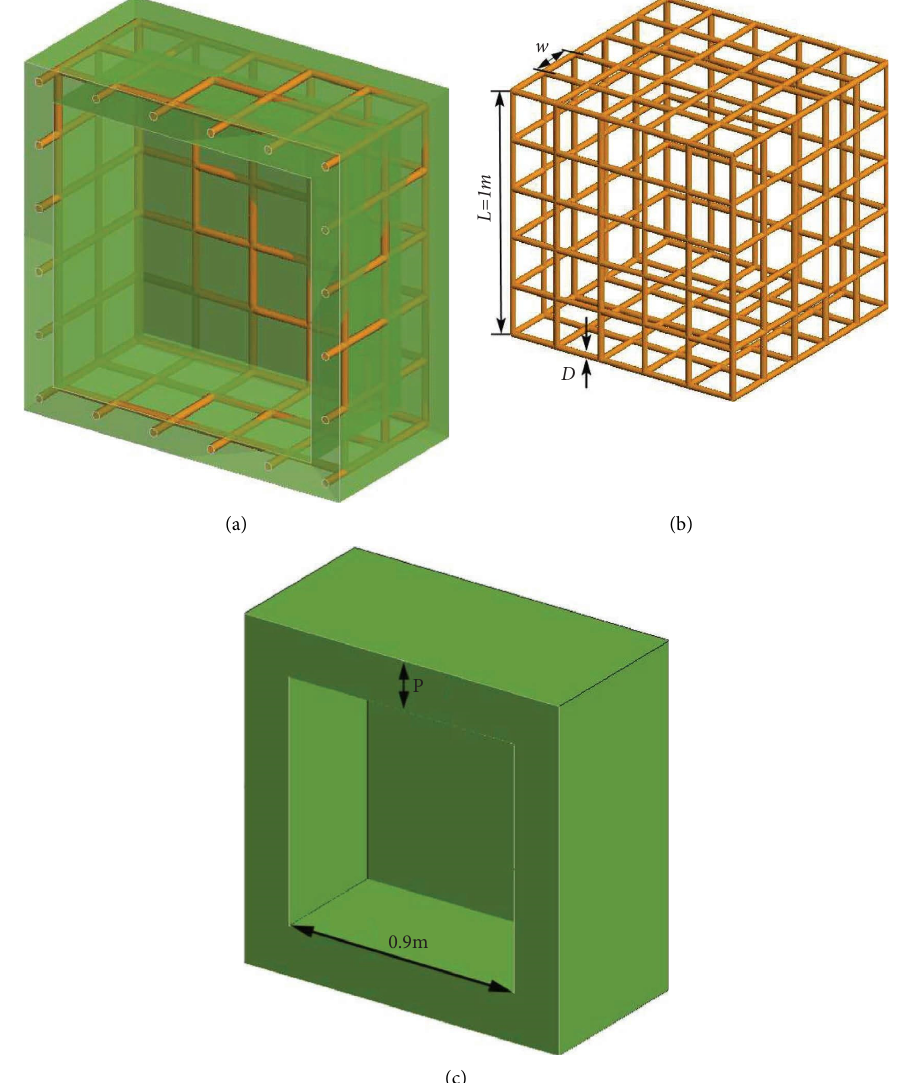
Figure 1: Diferent three-dimensional shielding cavity model: (a) reinforced concrete cavity, (b) steel cage, and (c) concrete